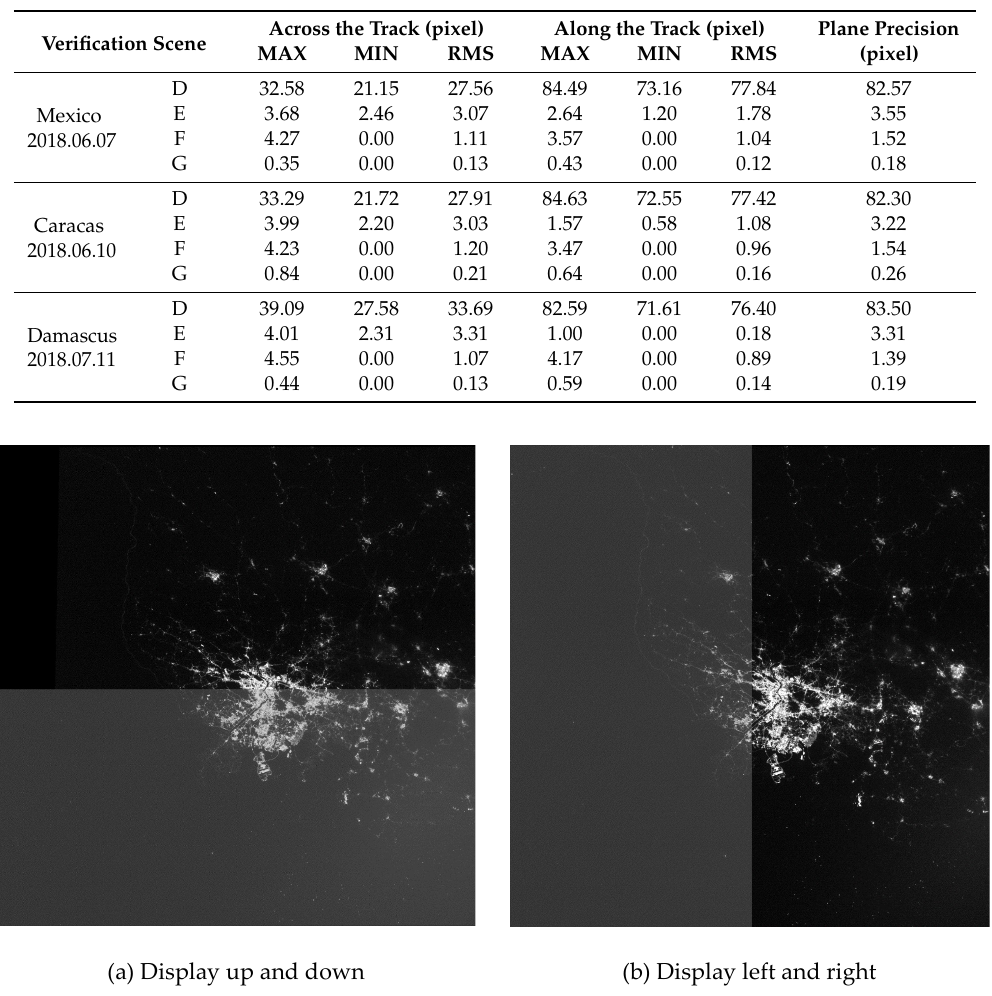
Figure 13. Korea shutter display after multi-temporal registration.